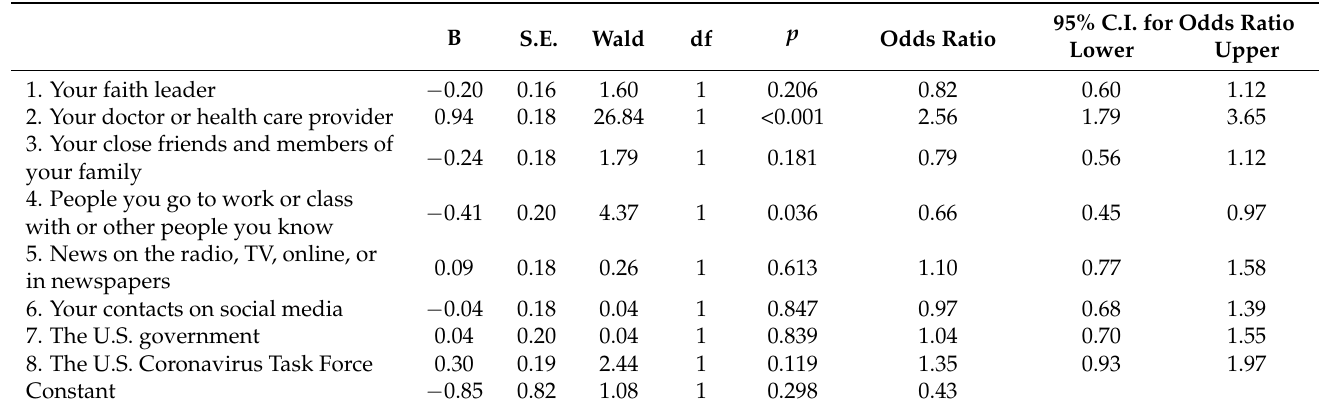
Table 3. Logistic regression predicting COVID-19 vaccine uptake from trusted sources.